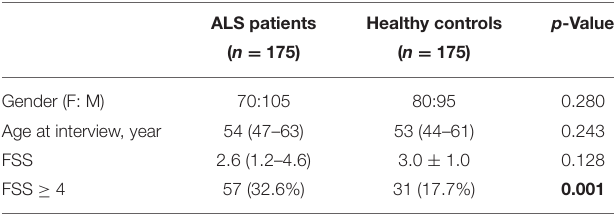
TABLE 1 | Demographic and clinical characteristics of patients with ALS and healthy